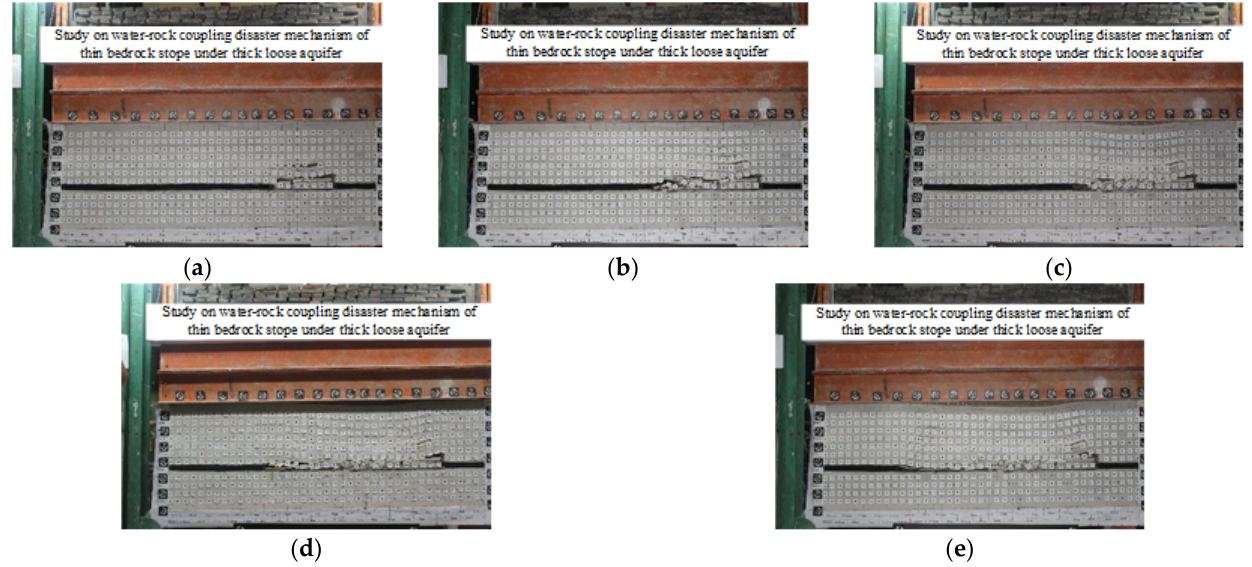
Figure 3. Migration characteristics of the stope overburden. ( a ) Stoping 50 m. ( b ) Stoping 70 m. ( c ) Stoping 85 m. ( d ) Stoping 120 m. ( e ) Stoping 130 m.